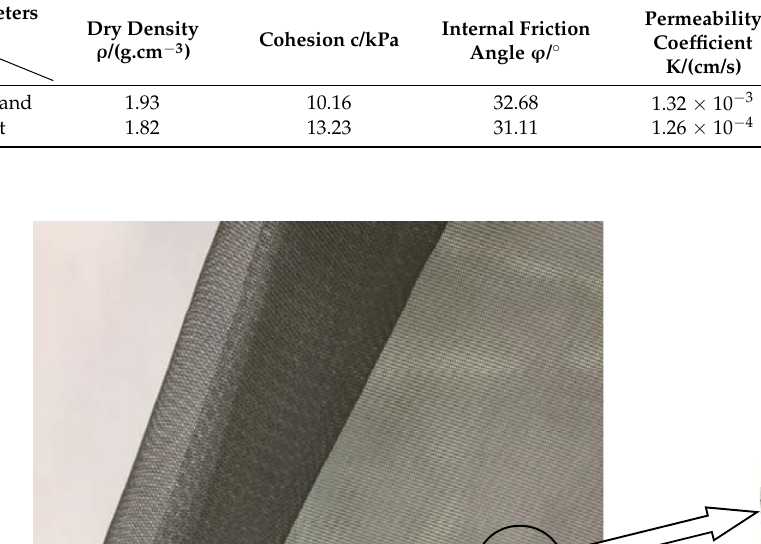
Table 1. Physical parameters of the experimental materials.